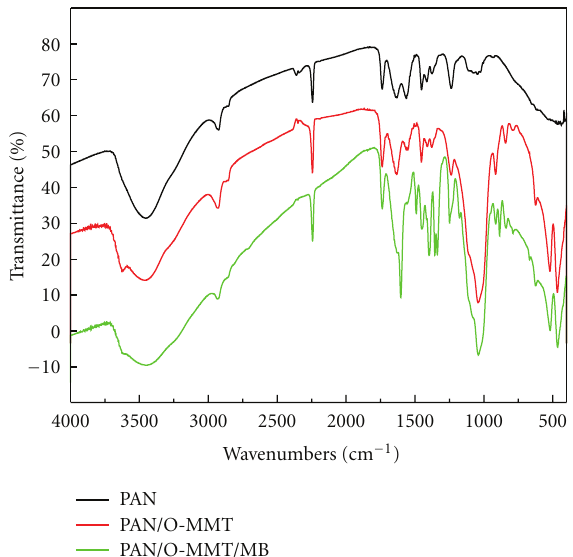
Figure 4: FTIR spectra of PAN, PAN/O-MMT nanofibers, and PAN/O-MMT nanofibers adsorbed with MB.